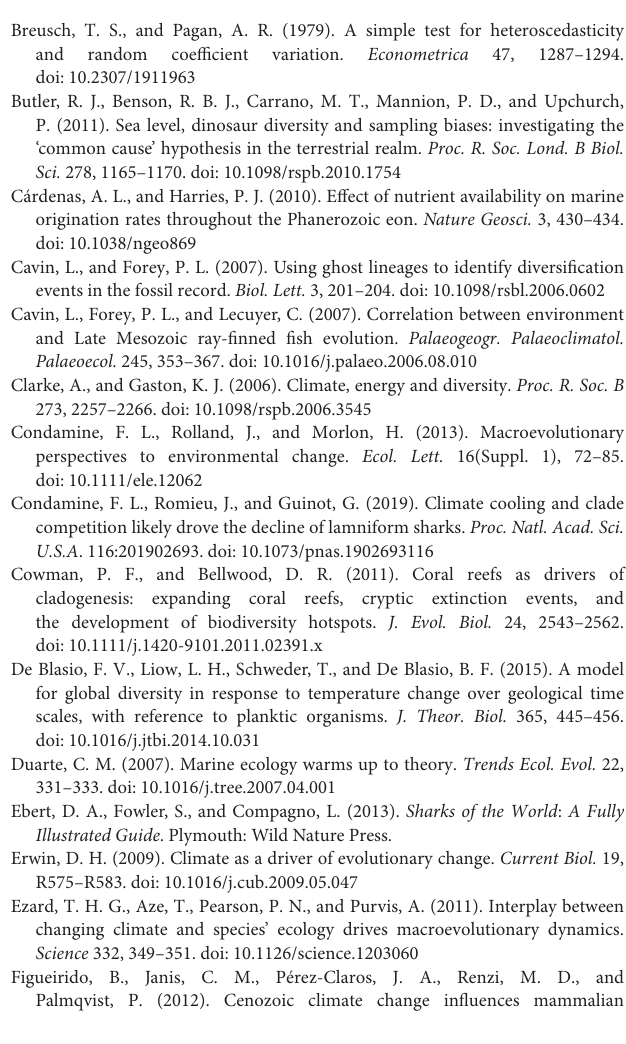
Supplementary Data 3 | Results of generalized least square analyses on elasmobranch data. Supplementary Data 4 | Results of generalized least square analyses on marine actinopterygian data. Supplementary Data 5 | Results of generalized least square analyses on freshwater actinopterygian data. Supplementary Data 6 | Results of generalized least square analyses on PDE data of elasmobranch, marine, and freshwater data using the number of fossil collections as proxy for